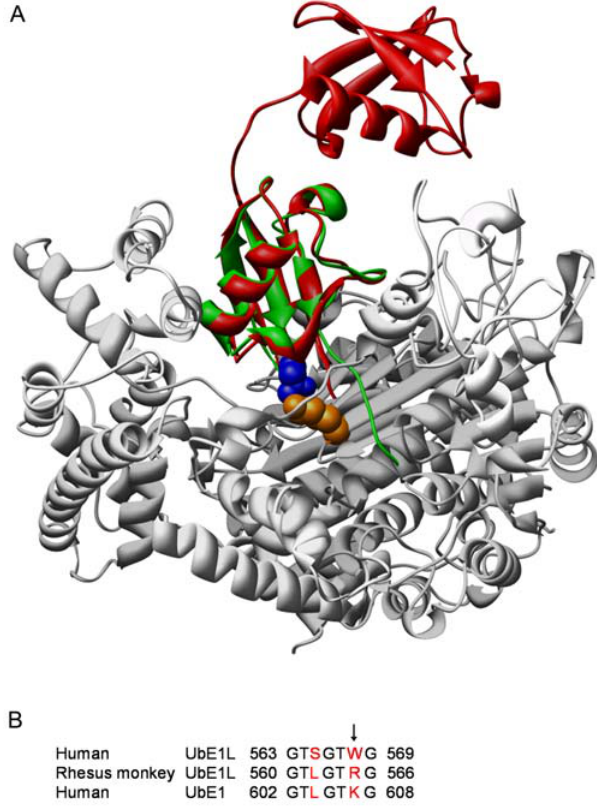
Figure 6. Residue 89 in ISG15 is situated in the predicted contact area with its Activating enzyme. (A) ISG15 (red ribbons) overlaid to Nedd8 (green ribbons) bound to its Activating enzyme AppBp1-Uba3 (grey ribbons). Residue 89 (dark blue) of ISG15, makes contact with residues in the two b -strands (shown in brown) of the Activating enzyme that precedes its C-terminal domain. K193 in Uba3 (orange) is located very close to N89, and corresponds to W568 in human UbE1L. The other residues of ISG15 with an important effect on total ISGylation, situated at positions 133 (yellow) and 31–33 (cyan blue), do not make contact with UbE1L and are likely to be involved in another feature of the ISGylation process. (B) HuUbE1L was aligned with HuUbE1 and RhmUbE1L (Ensembl peptide sequence EN- SMMUP00000027609). The region 563–569 in HuUbE1L shows two substitutions (S565L and W568R, red coloured) in the corresponding region of RhmUbE1L, which better resembles the corresponding region in HuUbE1